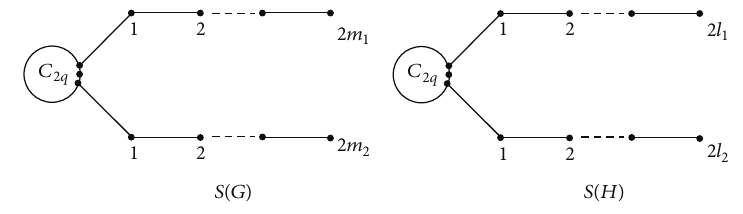
Figure 3: Two subdivision graphs.